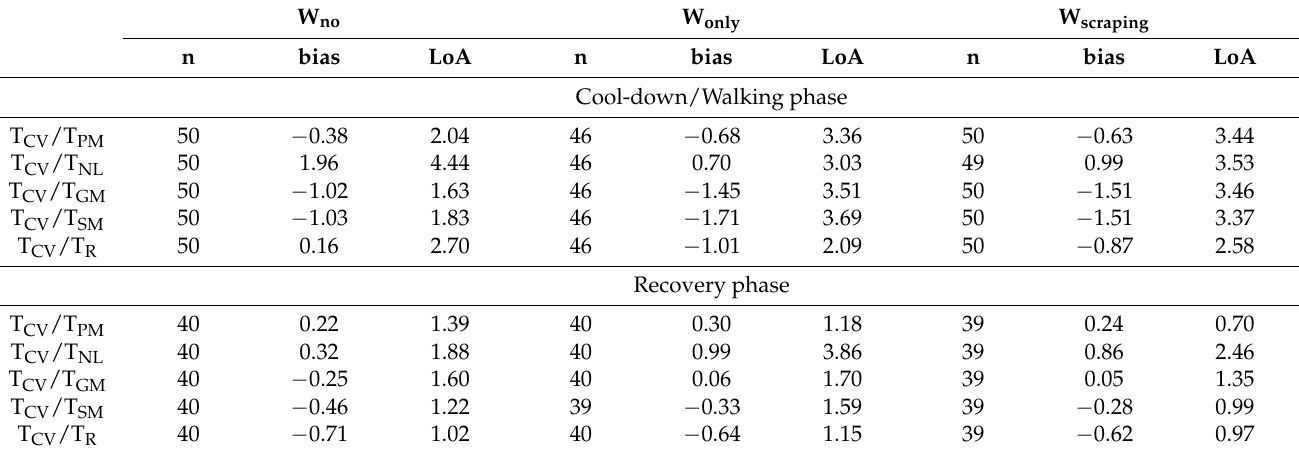
Table 2. Mean differences (bias) and limits of agreement range (LoA) between the central venous temperature, and the other body temperatures after treadmill exercise by cool-down